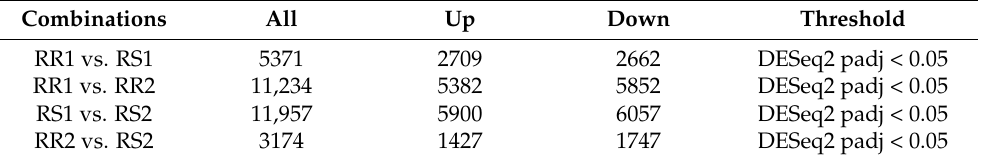
Table 1. Statistics of different genes.